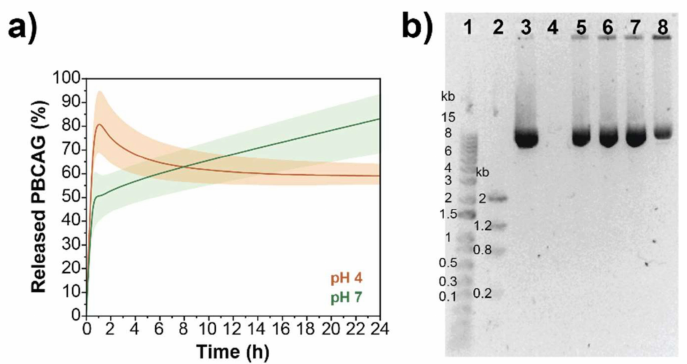
Figure 3. PBCAG release kinetics from PEG-PDHA NPs. ( a ) PBCAG release over a period of 24 h from PEG-PDHA NPs at 37 ◦ C in acid and neutral environments. ( b ) Representative gel electrophoresis of PBCAG release from PEG-PDHA NPs. Well 1: 1 kb DNA ladder, Well 2: low DNA mass ladder, Well 3: PBCAG (6.34 kb), Well 4–8: PEG-PDHA NPs encapsulating PBCAG after 0, 0.5, 1, 3, and 24 h incubation at 37 ◦ C,